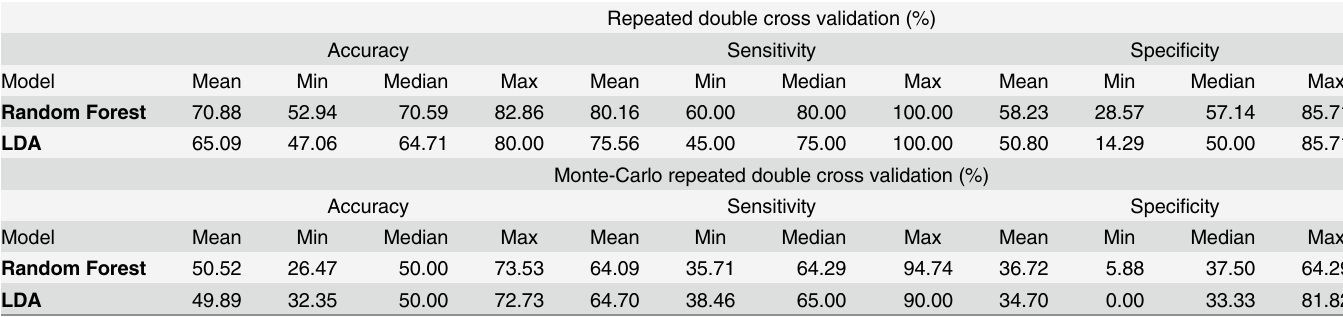
Table 8. Accuracy results of repeated double cross validation of the Random Forest and Linear Discriminant Analysis (LDA) models built to clas- sify patients with prostate cancer and cancer-free controls based on blood PSA levels and urinary